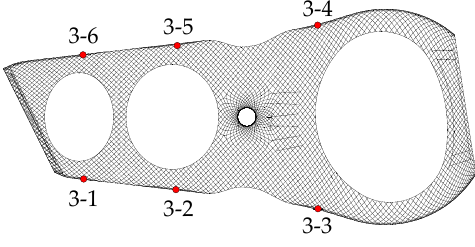
Figure 1. Stress monitoring point of the support connecting rod.